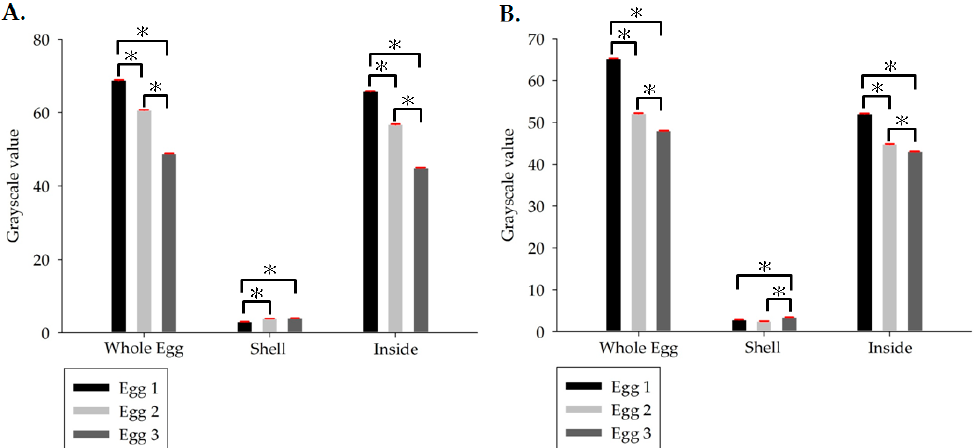
Figure 5. Results of the stratification analysis of visualization and one-way analysis of variance (ANOVA) test are presented for eggs of three different qualities: (Egg 1) SO eggs, (Egg 2) GO eggs, and (Egg 3) CO eggs among the whole eggs, shell, and inner egg. ( A ) Statistical results of stratification analysis of median plane image data visualization in Figure 3A–C. ( B ) Statistical results of stratification analysis of axial plane image data visualization in Figure 4A–C. The p values less than 0.05 are summarized with one asterisk.